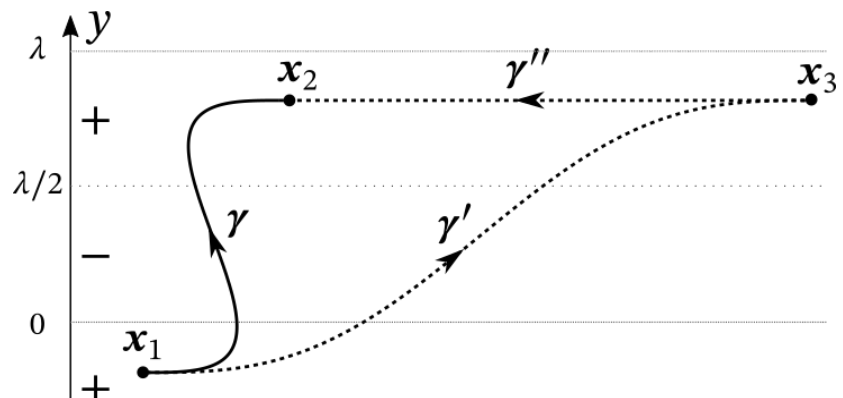
Figure 4: The two alternative paths from the starting point x In the limit of large (cid:107) x estimate (30), while subsequent evolution along γ (cid:48)(cid:48) has no effect on the winding index, Lemma 1